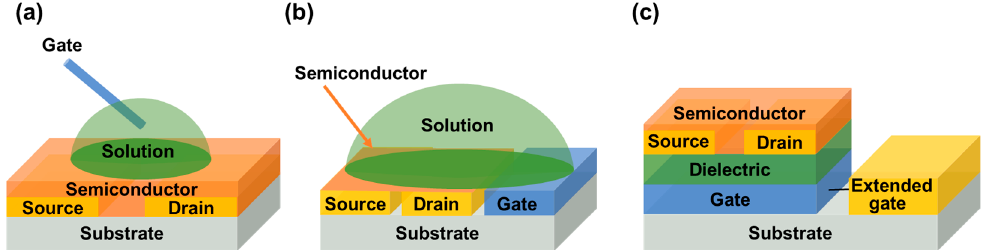
Figure 2. Schematic representation of three configurations of EGFETs. ( a ) Top − gate structure. ( b ) Side − gate architecture. ( c ) Extended − gate structure.